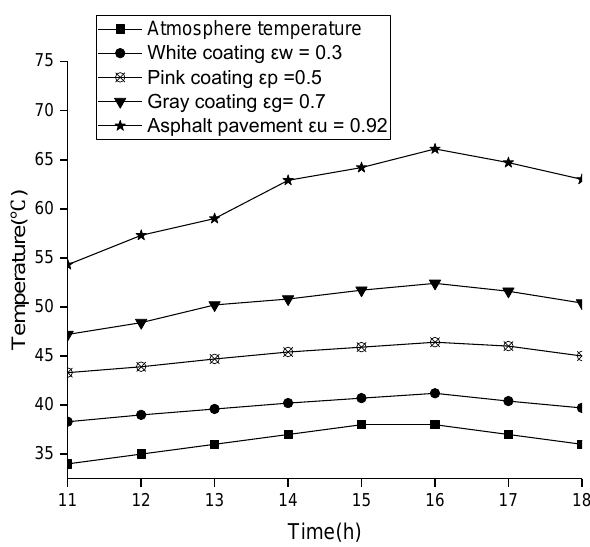
Figure 16. Temperature curves of different coating pavements.